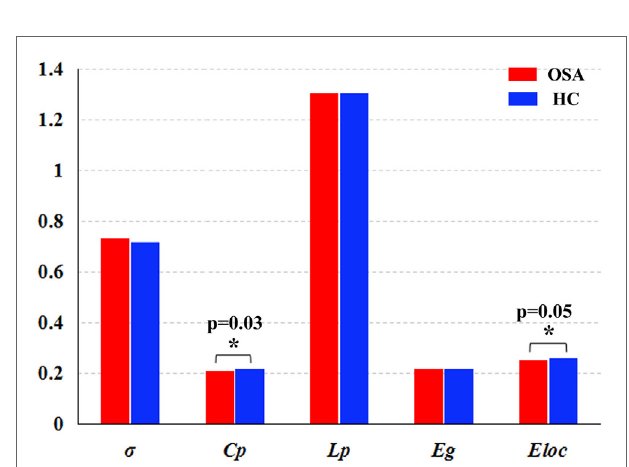
FigUre 5 | Graphs showing the small-world parameters and network efficiency of the default mode network in patients with obstructive sleep apnea (OSA) and good sleepers (GSs). Although OSA and GSs have typical small-world topology, compared to GSs, patients with OSA showed a significantly decreased C p ( t = − 2.200, p = 0.030) ( p < 0.05, uncorrected), and a decreased E loc ( t = − 1.943, p = 0.054), which have a trend for difference.